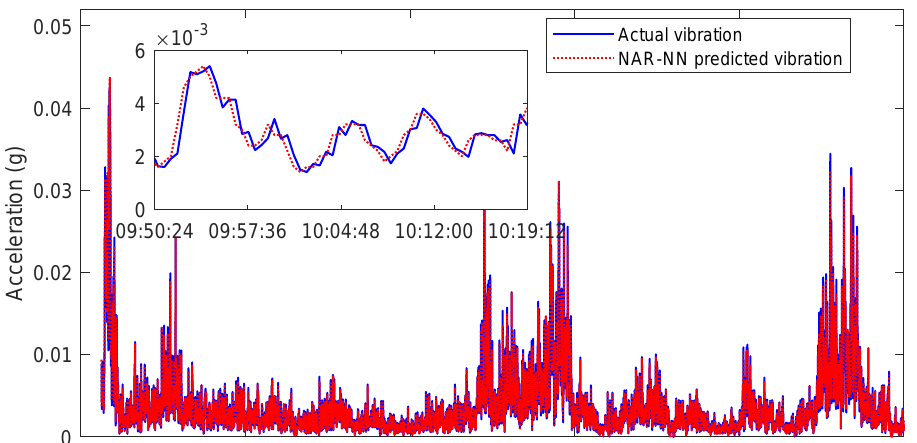
Figure 10. NAR-NN training results for gearbox vibration data.